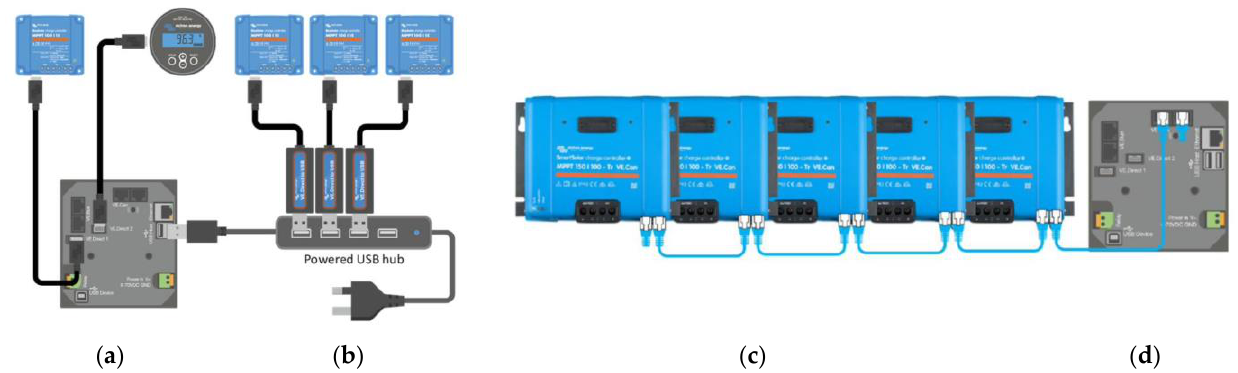
Figure 8. Two hardware connection alternatives for the synchronized operation of several MPPT controllers. ( a ) Cerbo GX ( b ) Powered USB hub ( c ) MTTPs serial network ( d ) Cerbo GX.